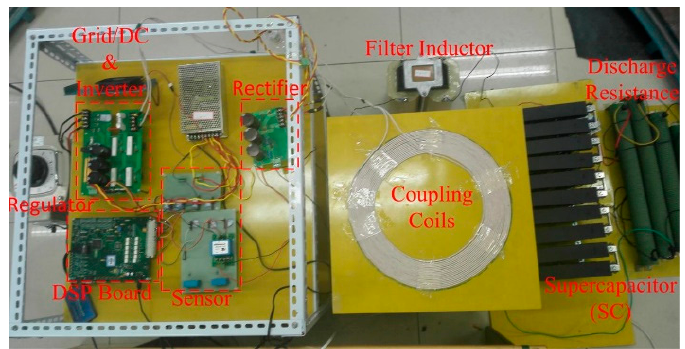
Figure 12. Demo SC-load WPT system.